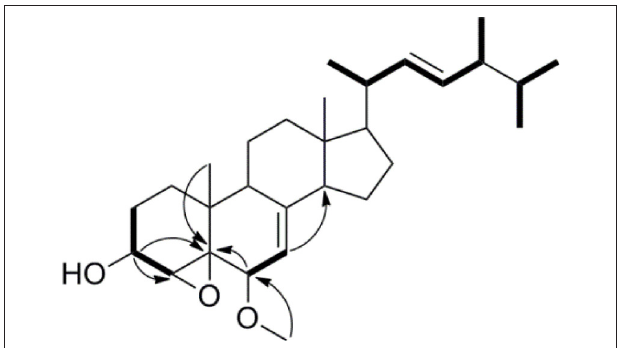
FIGURE 4 | Key HMBC and 1 H- 1 H COSY correlations of compound 1